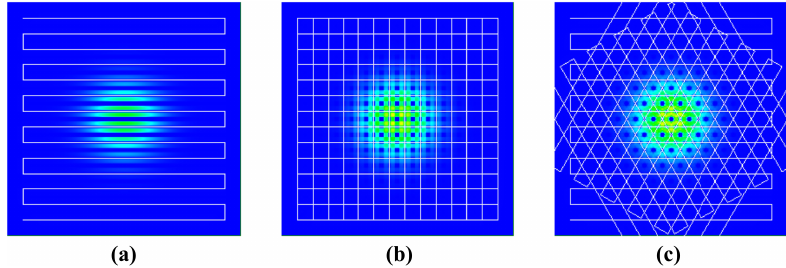
Figure 19. Search patterns: one look (A), two looks (B) and three looks